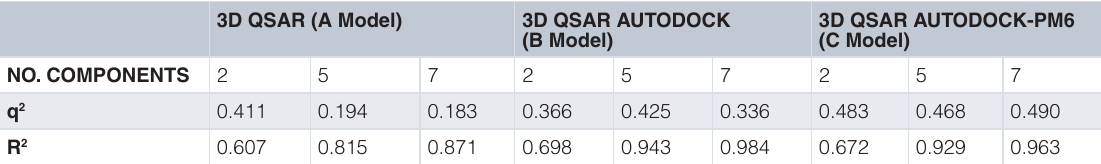
Table 2. Statistical prediction descriptors (q 2 ) and correlation (R 2 ) of the three models, 3D QSAR to 2, 5 and 7 components. 3D QSAR (A